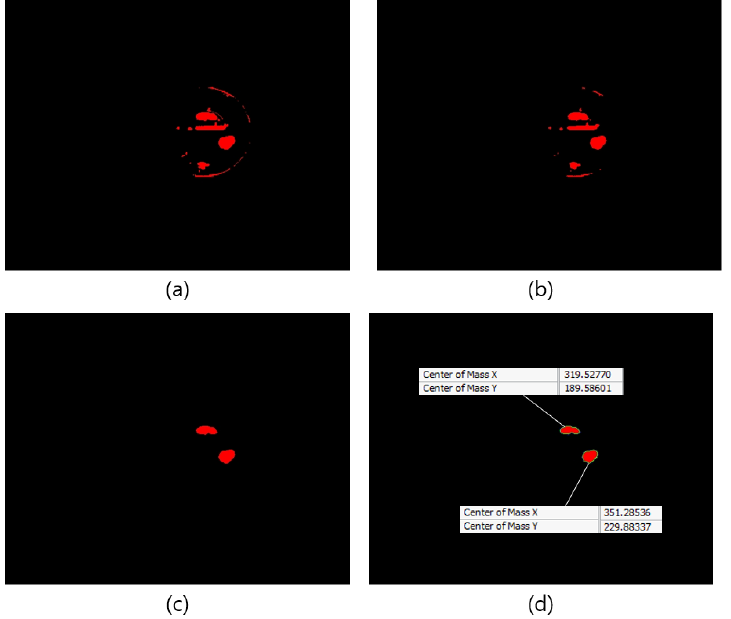
Figure 6. Example of binary image processing: ( a ) grayscale image is converted into a binary image, ( b ) low-pass filter is utilized, ( c ) small objects are removed, and ( d ) the object’s coordinates are